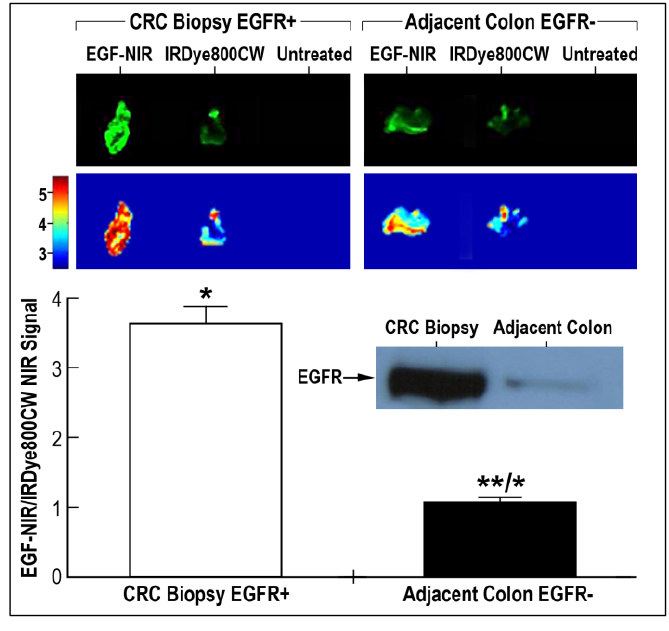
Figure 7. Bio-imaging of EGF-NIR binding to CRC tissues expressing high levels of EGFR, compared with adjacent colon tissues negative for EGFR expression. Slices ( n = 4) of the different tissues ( n = 19) were submitted for ex vivo binding assay of 45 min at 37 °C with 70 nM EGF-NIR. In control experiments, background fluorescence was measured in untreated slices and nonspecific absorption was measured in slices treated with 70 nM IRDye800CW. The NIR intensity was estimated at identical conditions for all slices ( n = 76); NIR imaging was estimated at the following conditions: resolution: 170–340 microns; pixel area: 0.03 mm 2 ; quality: medium-low; focus offset: 1; channels: 800 nm; intensity: 3; Significance: * p < 0.01 compared to IRDye800CW; ** p < 0.05 compared to CRC biopsy EGFR+. Upper inserts: NIR scans; Middle inserts: western blotting for